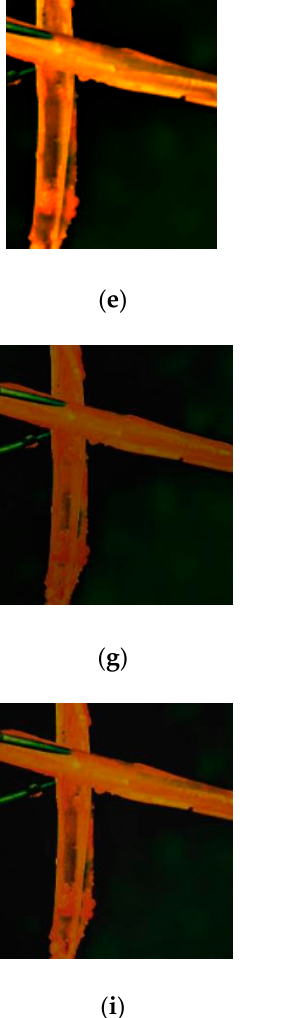
Figure 8. The simulation results of image 3. ( a – d ) are the simulated displayed images processed by the four algorithms, the regions in the red circles in ( a – d ) are enlarged and shown in ( f – i ), ( e ) is the same region of the reference image. ( a ) GFWA, ( b ) LUT, ( c ) FWA, ( d ) ISFLA, ( e ) Reference resources, ( f ) GFWA, ( g ) LUT, ( h ) FWA, ( i ) ISFLA.